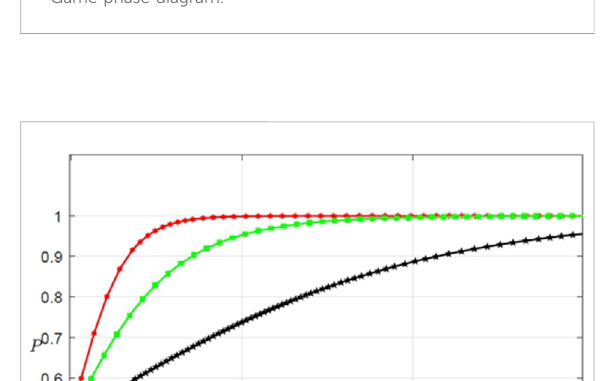
FIGURE 3 Game phase diagram.